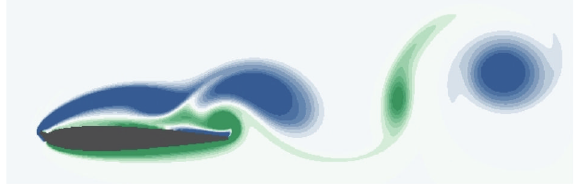
Figure 13: Established iced NACA 0012 solution at Re = 1000. Vor- ticity contours: green positive vorticity and blue negative vorticity.